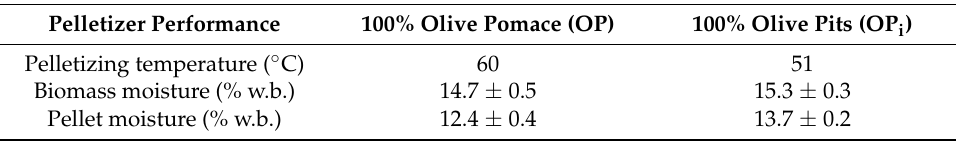
Table 1. Operating pelletization